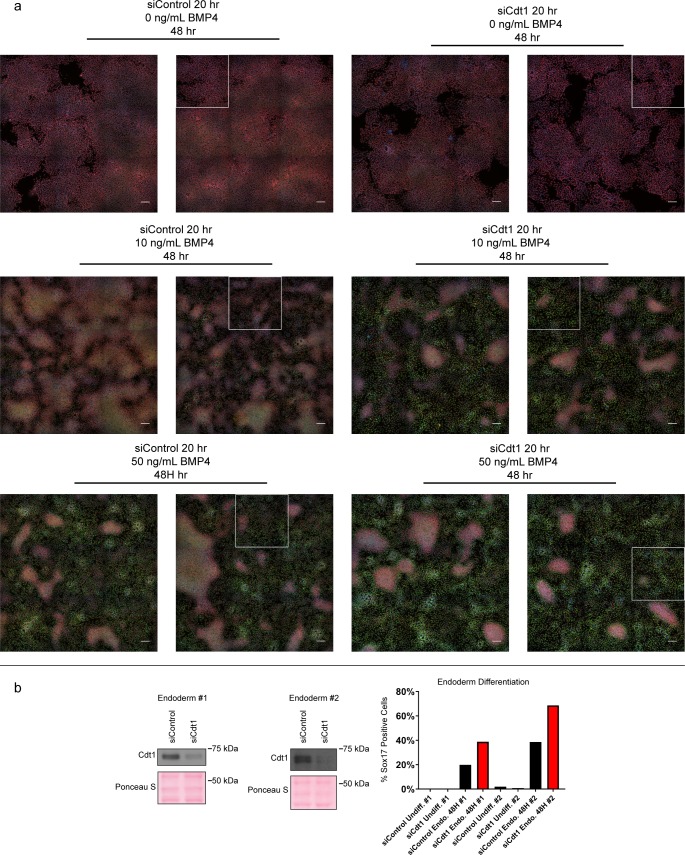
Complete microscopy dataset and endoderm differentiation.(a) Complete immunofluorescence microscopy data for Figure 7. White boxes mark the areas shown in Figure 7b; scale bars are 100 μM. (b) Immunoblots for Cdt1 in whole cell lysates of hESCs treated with 100 nM siControl or siCdt1 for 24 hr prior to initiating differentiation toward endoderm, two biological replicates. Bar graph indicates the percentage of Sox17-positive cells, n > 2,300 cells per condition. See also Figure 7—source data 1.